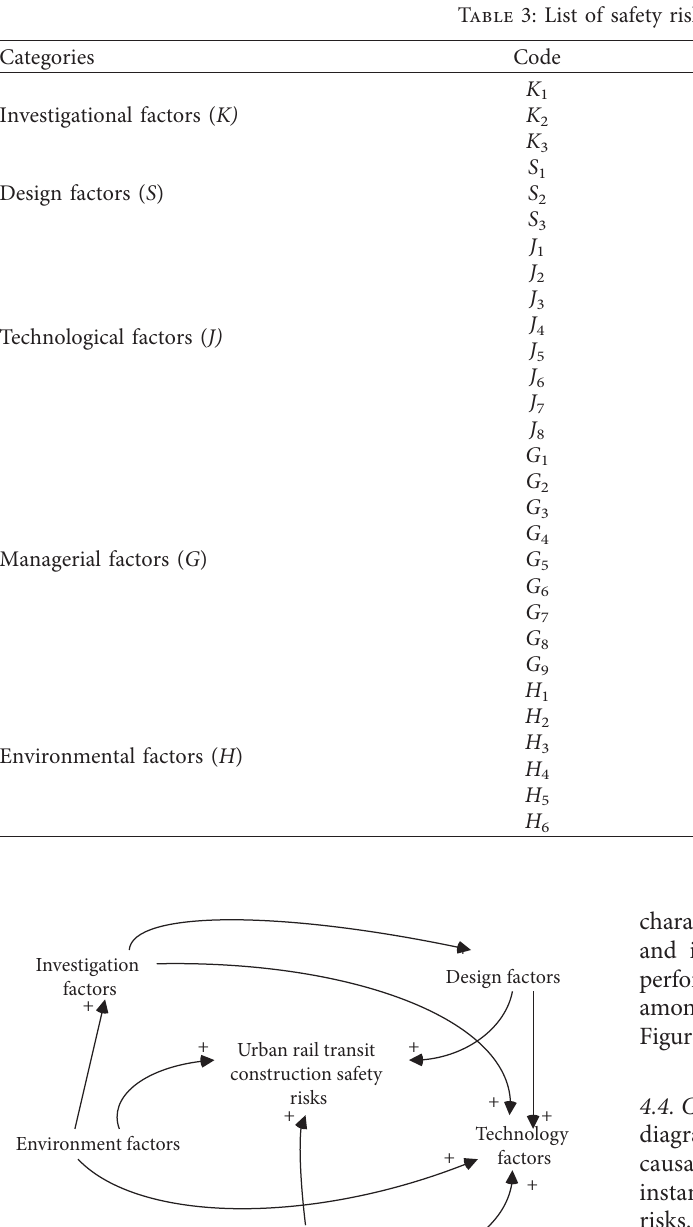
Table 3: List of safety risk factors.